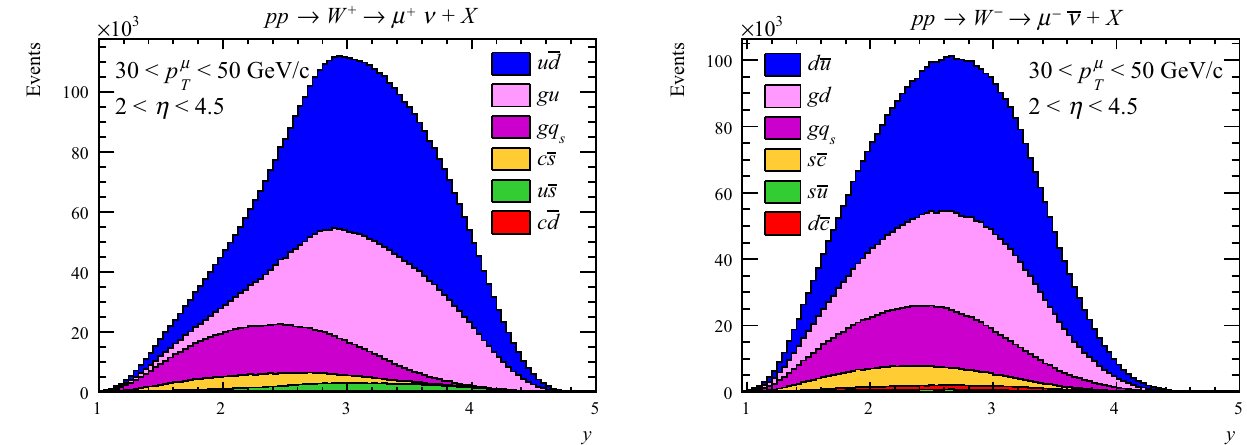
Fig. 3 The (left) W + and (right) W − rapidity distributions decomposed into the main partonic subprocesses